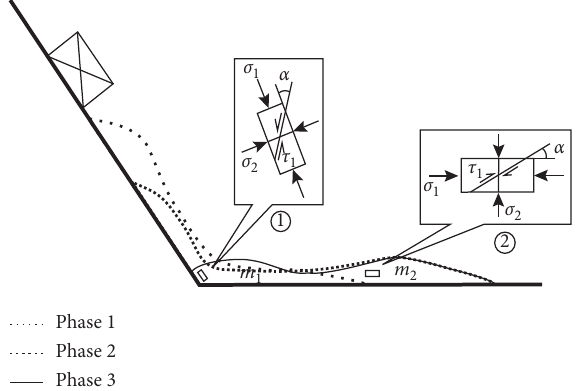
Figure 13: Schematic illustration of shear force of